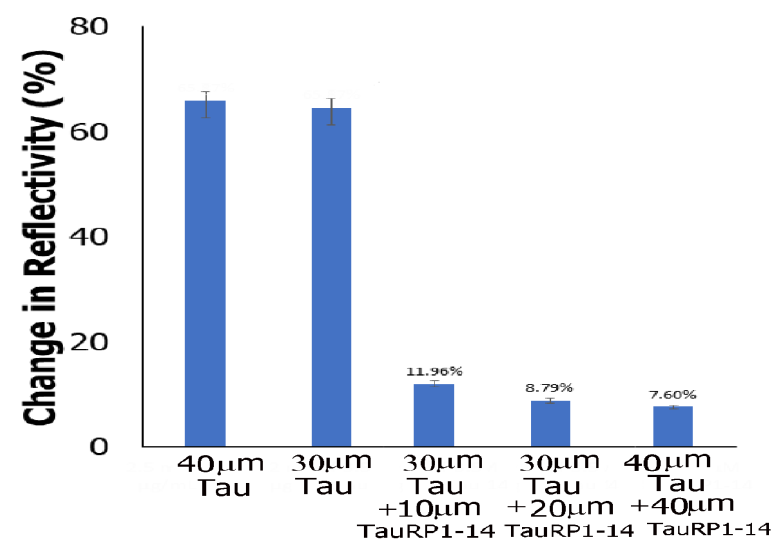
Figure 10. Comparison of change in percent reflectivity upon interaction of LRP1-expressed immobilized HEK-293 cells with neat Tau fibrils and Tau fibrils pre-associated with different concentrations of TauRP1-14 peptide.